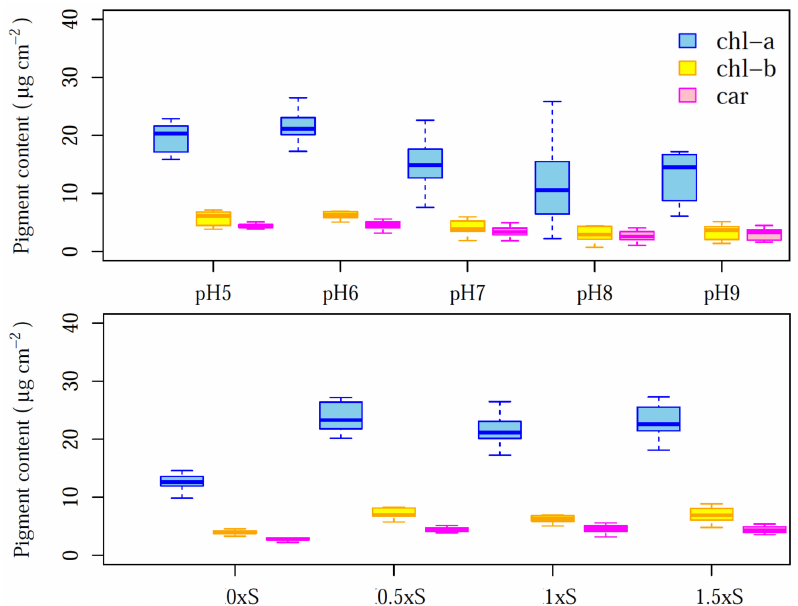
Figure 2. Boxplots of chl a , b and car for di ff erent pH conditions or sulphur ion concentrations (S strength). Although the highest contents were observed for the standard pH condition, 0.5 × S was e ff ective for the increase in photosynthetic pigment contents.